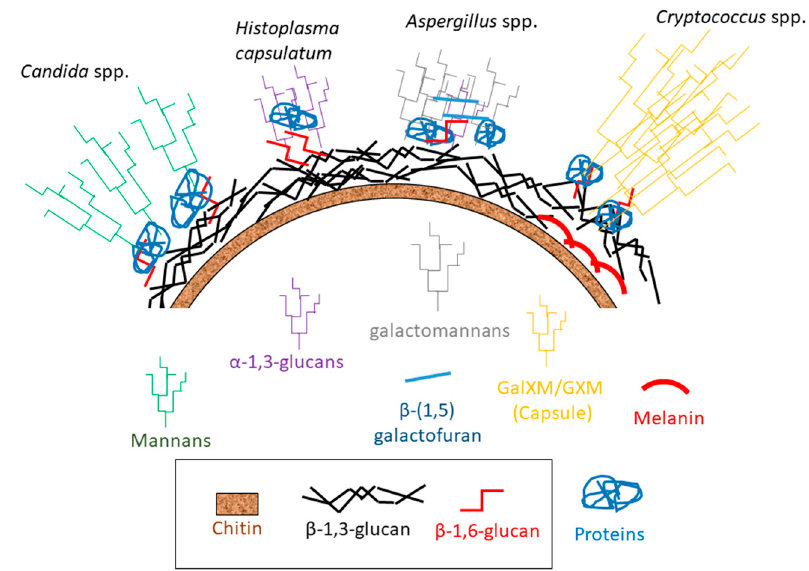
Figure 2. Schematic representation of fungal cell walls of the main fungal human pathogens following the hypothesis proposed by Gow et al. [32]. Alkali-insoluble core components: chithin and branched β -(1,3) and β -(1,6) glucans (black box).